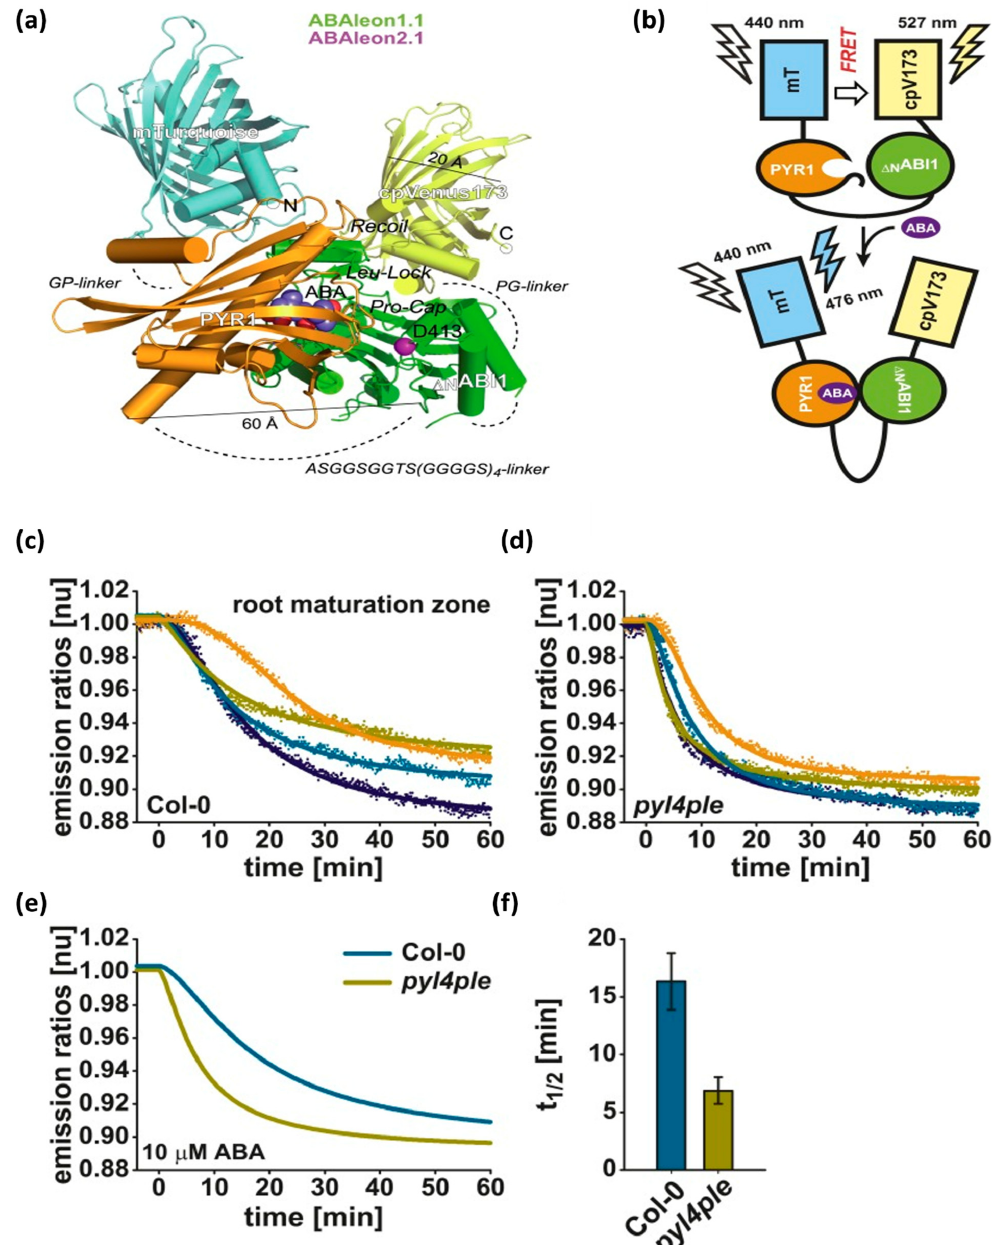
Figure 6. ( a ) Structural features of ABAleon, where mTurquoise (mT) (cyan color) is fused to PYR1 (gold color) and Δ N ABI1 (green color) is fused to cpVenus173 (cpV173) (yellow color). ( b ) FRET from mT to cpV173 without ABA and FRET quenching with ABA. ABA response curves of ( c ) Columbia ‐ 0 wild type and ( d ) pyl4ple. ( e ) Data from four single measurements were fitted by a four ‐ parameter logistic curve to obtain the combined dataset. ( f ) The t 1/2 values calculated from the fitted curves in ( c , d ) [194] Copyright © eLifeSciences, Waadt et al.